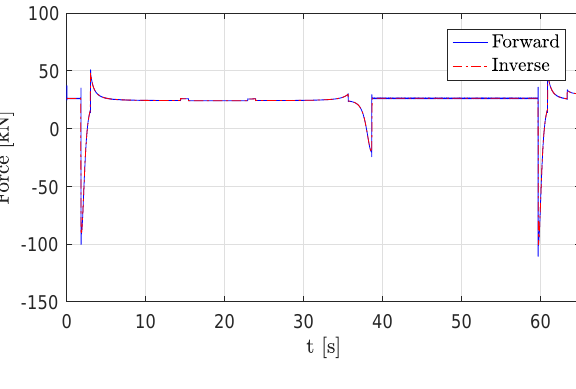
Figure 14: Lifting cylinder axial force.